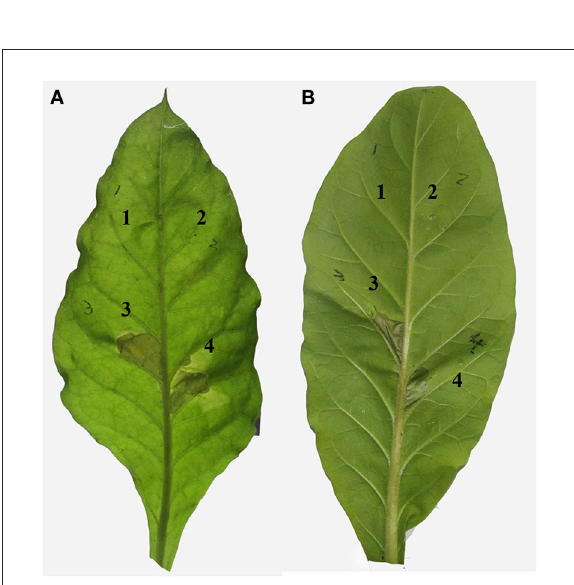
FIGURE3 Effect of hrcJ (A) and hrpE (B) on hypersensitive response in tobacco ( Nicotiana benthamiana ) leaves infiltrated with water (1), hrcJ or hrpE mutant strain 1 hrcJ or 1 hrpE (2), wild-type strain Aac-5 (3), and the complementation strain 1 hrcJ -comp or 1 hrpE -comp